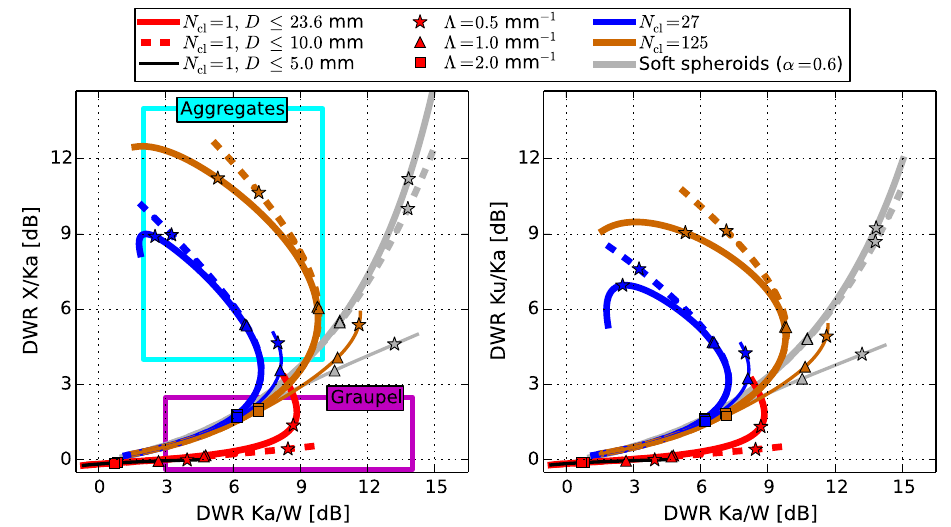
Figure 9. Impact of snowflake maximum diameter D max = 23 . 6 , 10 . 0 , 5 . 0mm on modeled snowfall triple-frequency radar signatures for exponential snowflake size distributions with exponential slope parameters of 0 . 3 ≤ (cid:51) ≤ 5 . 0mm − 1 . Modeling results for collections of N cl = 1, 27, 125 randomly distributed ice spheres inside the spherical snowflake bounding volume correspond to normalized surface-area- to-volume ratios of ξ = 1, 3, 5,